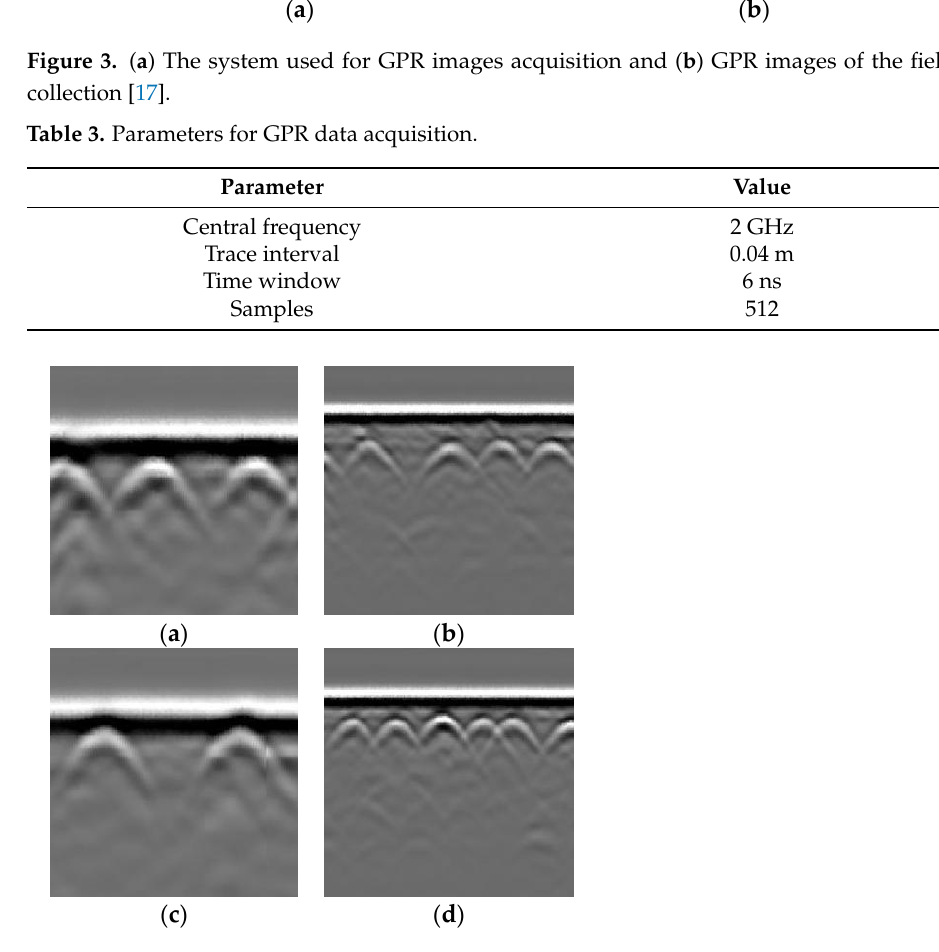
Figure 4. ( a – d ) Examples of field GPR images, in which rebars are easily recognized. Table 3. Parameters for GPR data